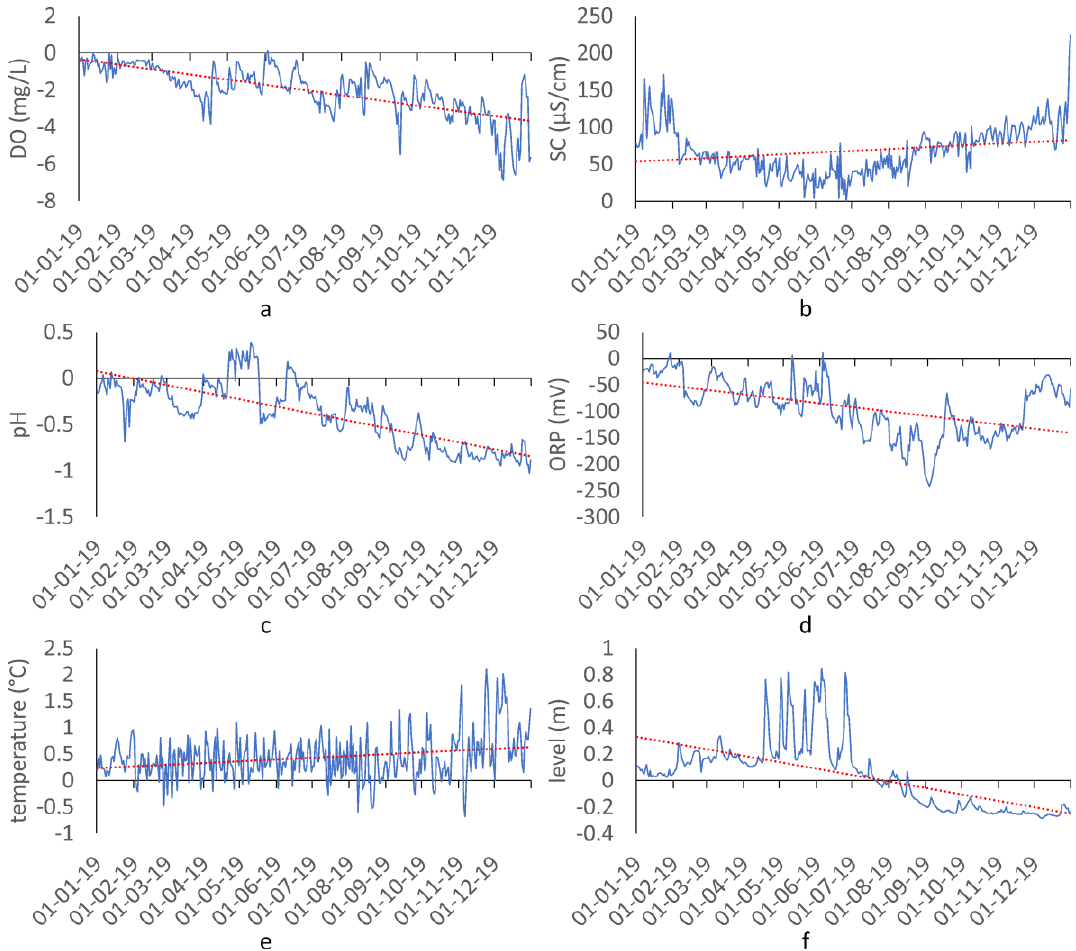
Figure 4. Comparative evolution of the difference between daily average values of the monitored parameters at Tişăuţi and Mihoveni in 2019 (the dotted red line is the linear trendline): ( a ) DO; ( b ) SC; ( c ) pH; ( d ) ORP; ( e ) temperature; ( f ) level.